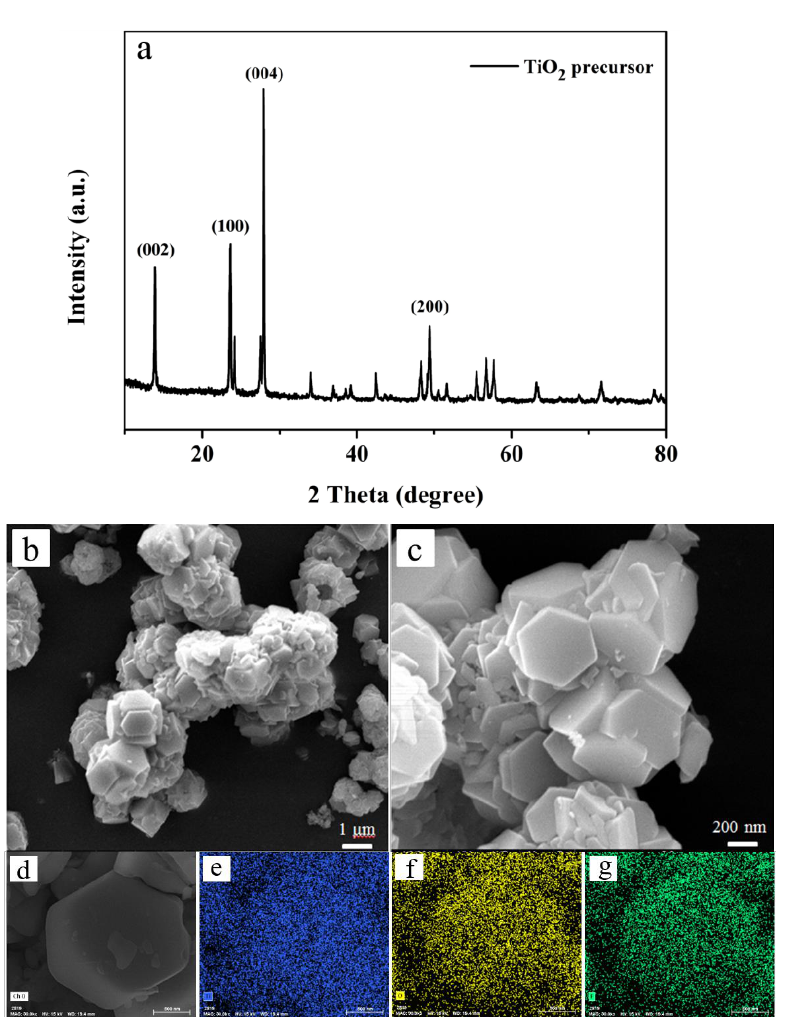
Figure 1. ( a ) XRD patterns; ( b , c ) SEM micrographs of TiO 2 precursor; ( d – g ) EDS images of TiO 2 precursor: Ti (blue), O (yellow) and F (green).